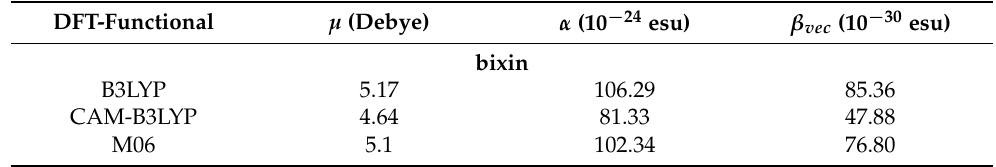
Table A15. Dipole moment ( µ ), average linear polarizability ( α ), and vector component of the first ( β vec ) hyperpolarizability of the dyes in gas phase. These results were obtained by employing the 6-31G(d,p) basis